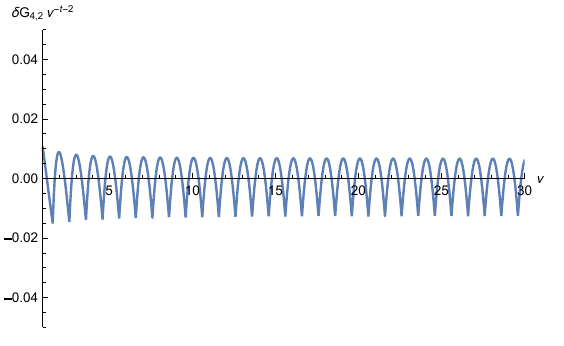
Figure 16 . Error for G 4 ; 2 . We plot the di(cid:11)erence between the l.h.s. and the r.h.s. in (7.11) for t = 1 : 2. The error is exactly as